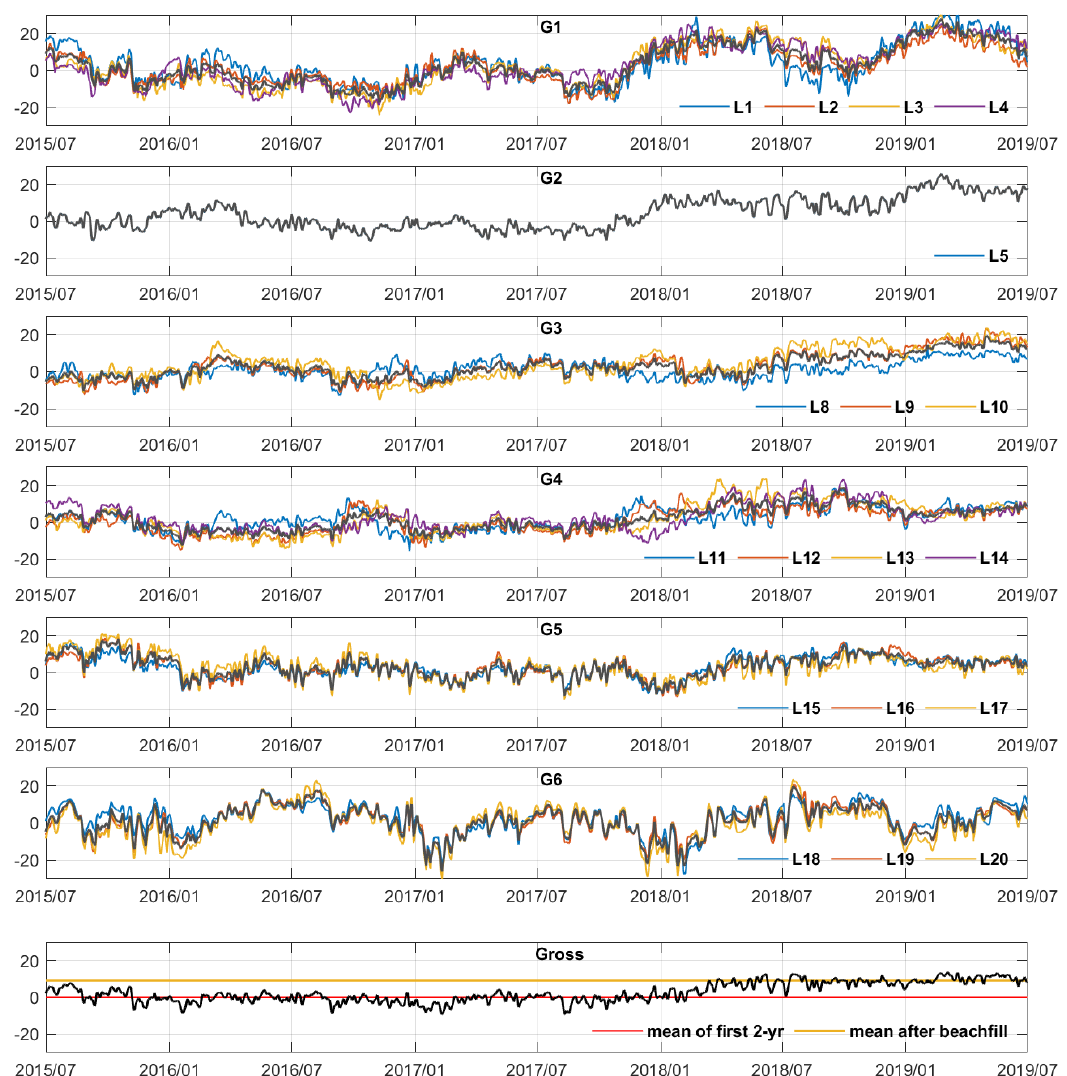
Figure 4. ( a – f ) Time series of classified beach width changes using the clustering result for sectors G1–G6 respectively, and ( g ) beach width change for all sectors. The red and yellow lines in ( g ) denote the mean level of beach width averaged over first 2-years and over the last 1-year of observation after the beachfill.